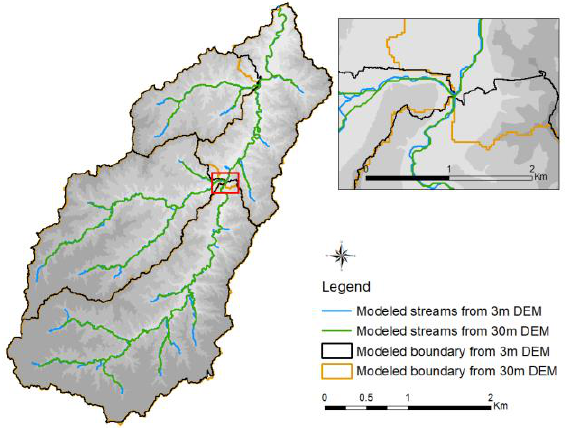
Figure 7. Watershed boundaries and drainage streams extracted from 3 and 30 m DEMs.